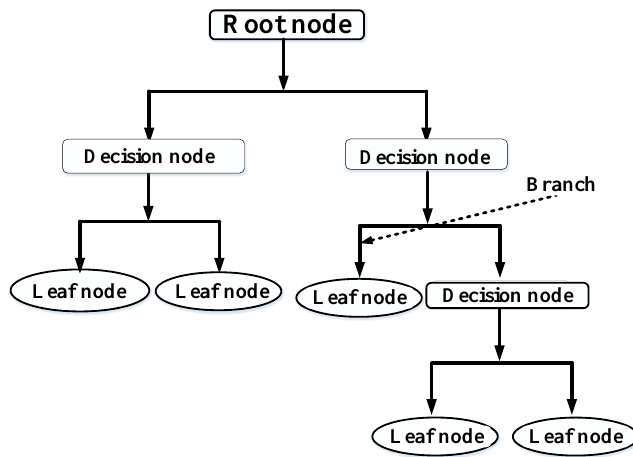
Figure 9. Structure of proposed multilevel inverter topology.